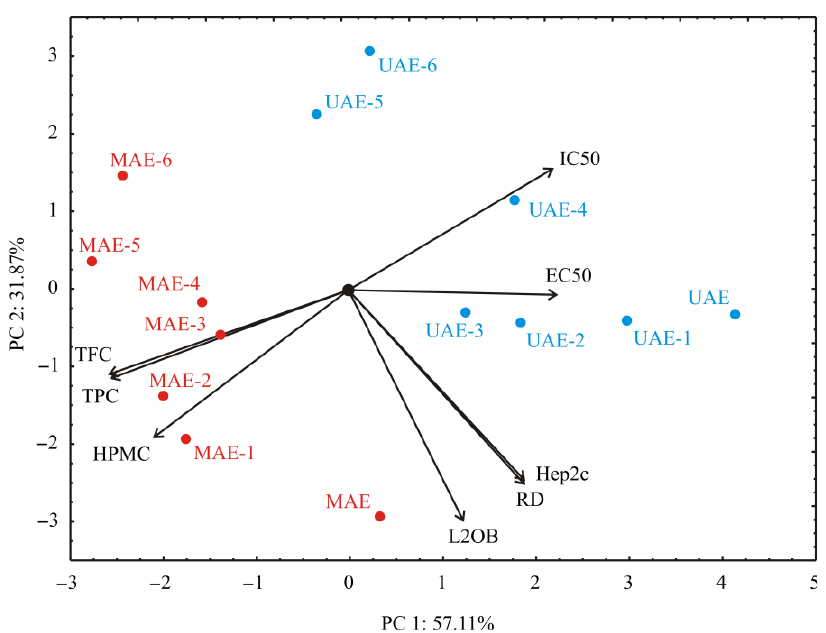
Figure 1. PCA ordination of variables based on component correlations.